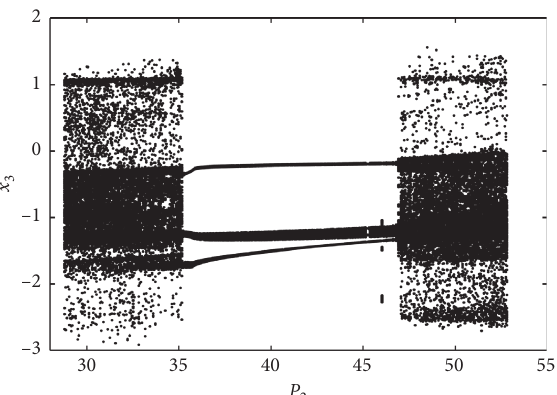
Figure 11: Bifurcation diagram for the second-order mode via external